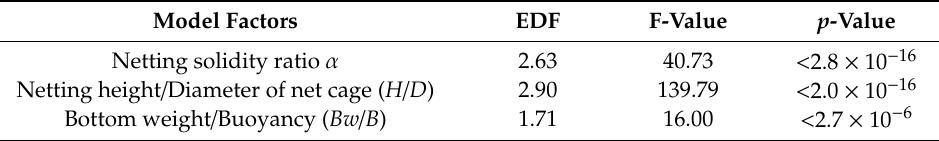
Table 4. Statistical results of GAM analysis for equivalent drag coefficient .